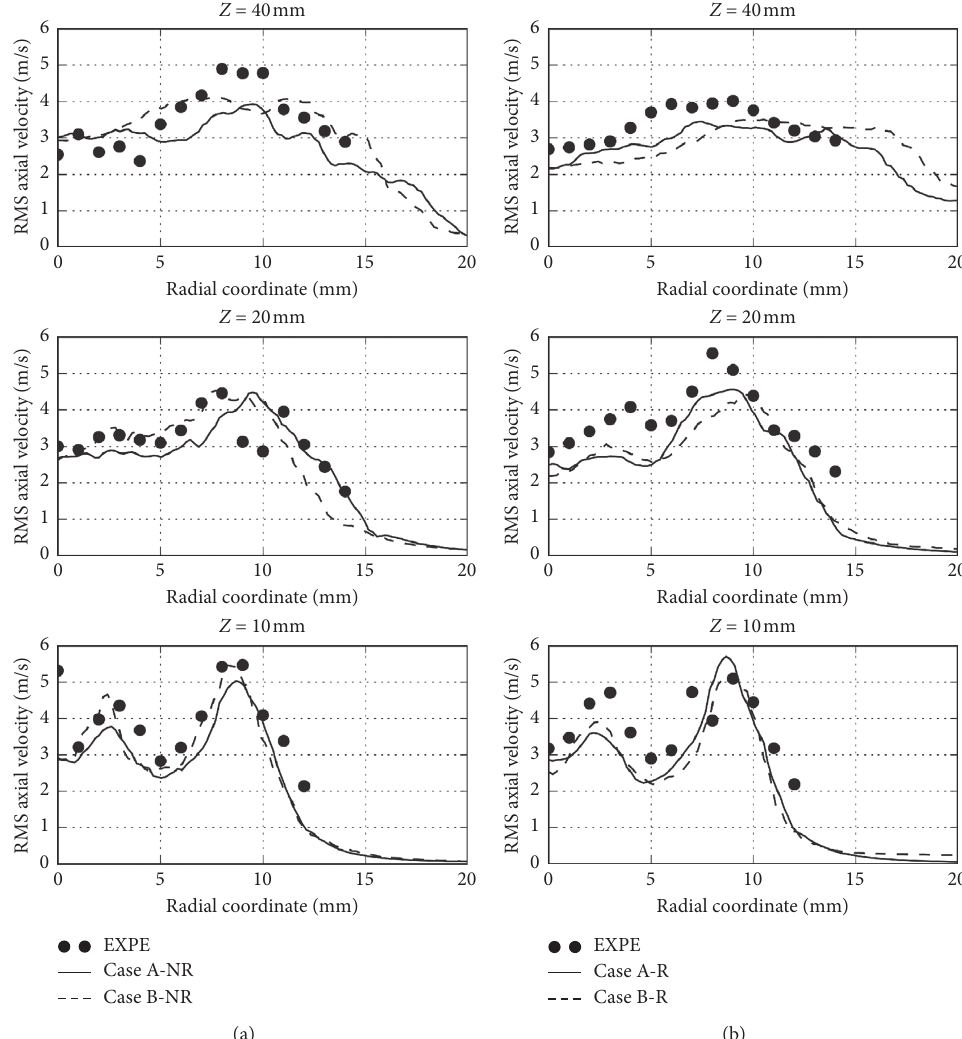
Figure 11: Radial profiles of axial velocity RMS for nonreacting (a) and reacting case (b). Symbols: experiments, solid line: case A dashed line: case